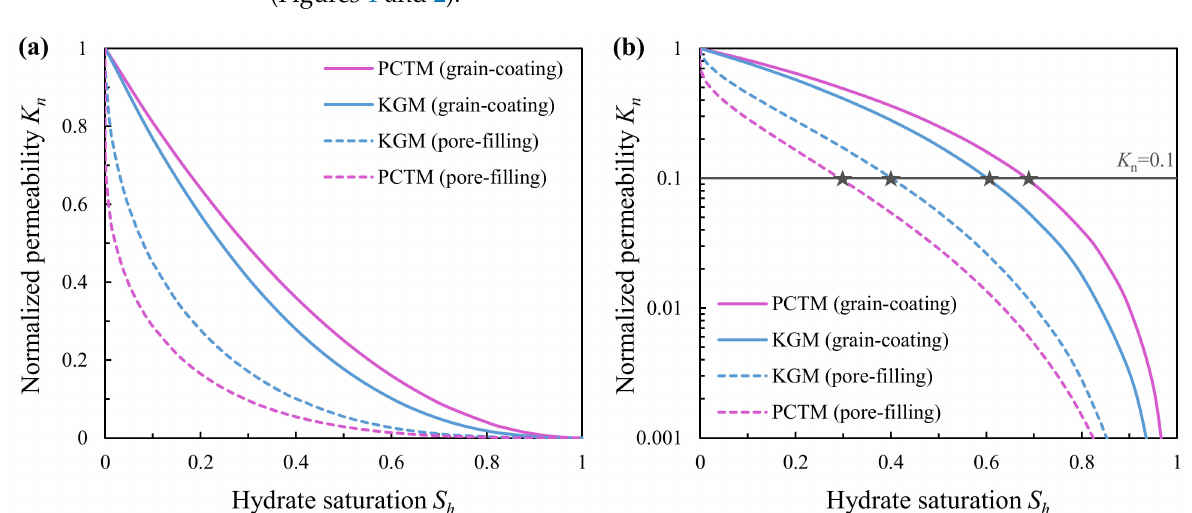
Figure 2. The K n - S h relationships of PCTM and KGM. ( a ) A description in the general coordinate system; ( b ) A description in the semilog coordinate